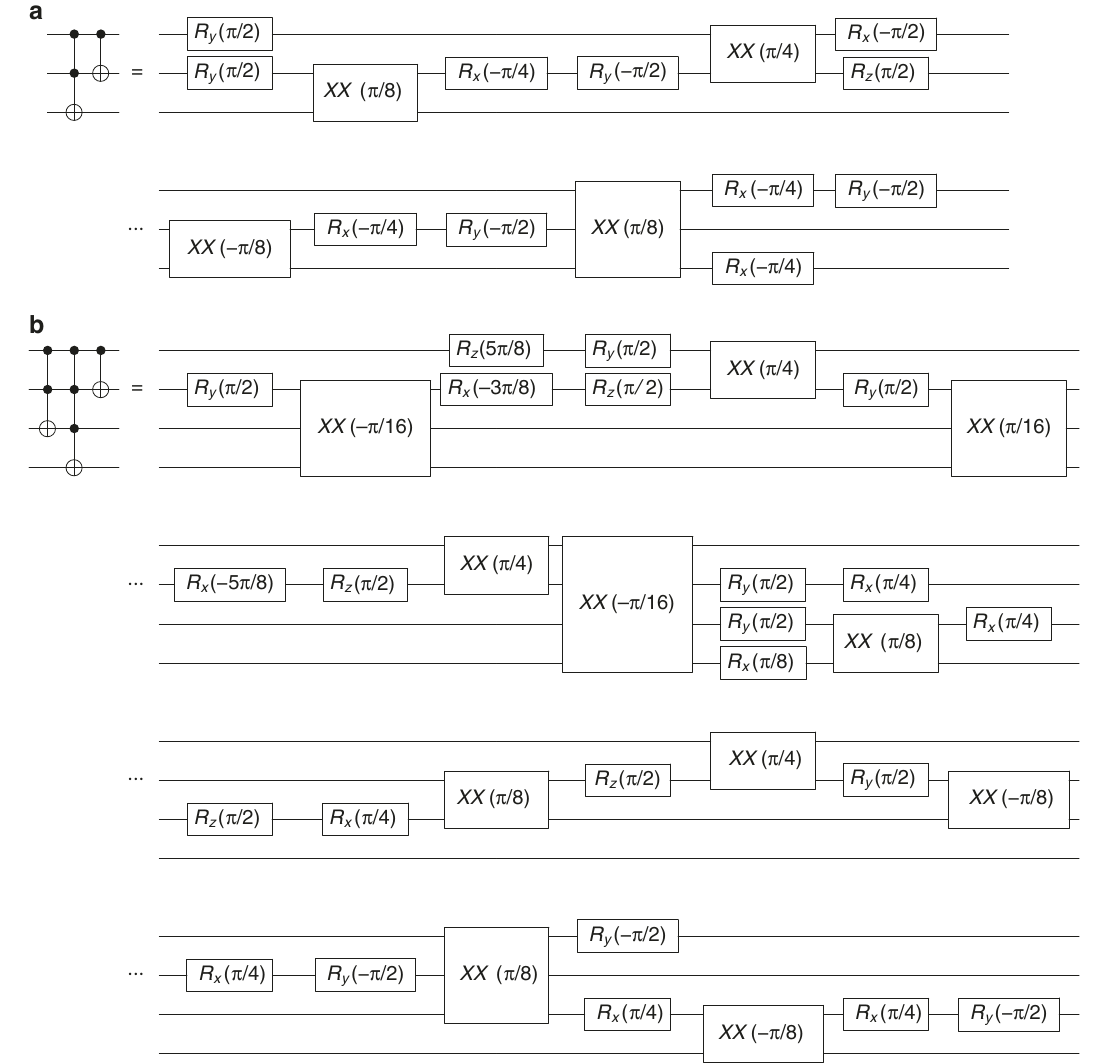
Fig. 6 Gate block. a Toffoli 4--CNOT and b Toffoli